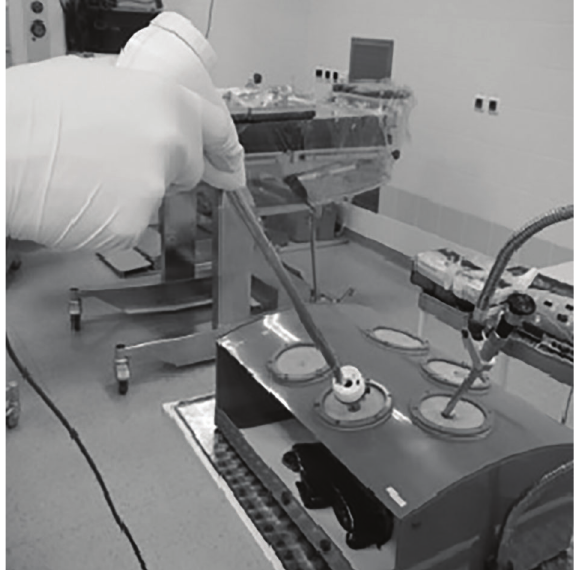
Figure 3. Ex vivo study. Use of laparoscopic simulator for the evaluation of the manipulation of the new